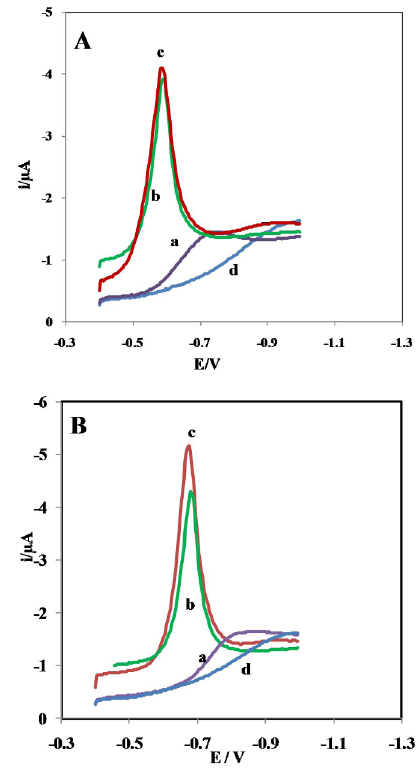
Figure 1. Differential pulse voltammetric responses of 160 µM of CA (A) and 160 µM of SY (B) at a bare glassy carbon electrode (a), bismuth modified glassy carbon electrode (b) and bismuth-chitosan thin film modified glassy carbon electrode (c) at pH 7 phosphate buffer solution (PBS). The voltammograms of d are the backgrounds. The scan rate was 50 mV s -1